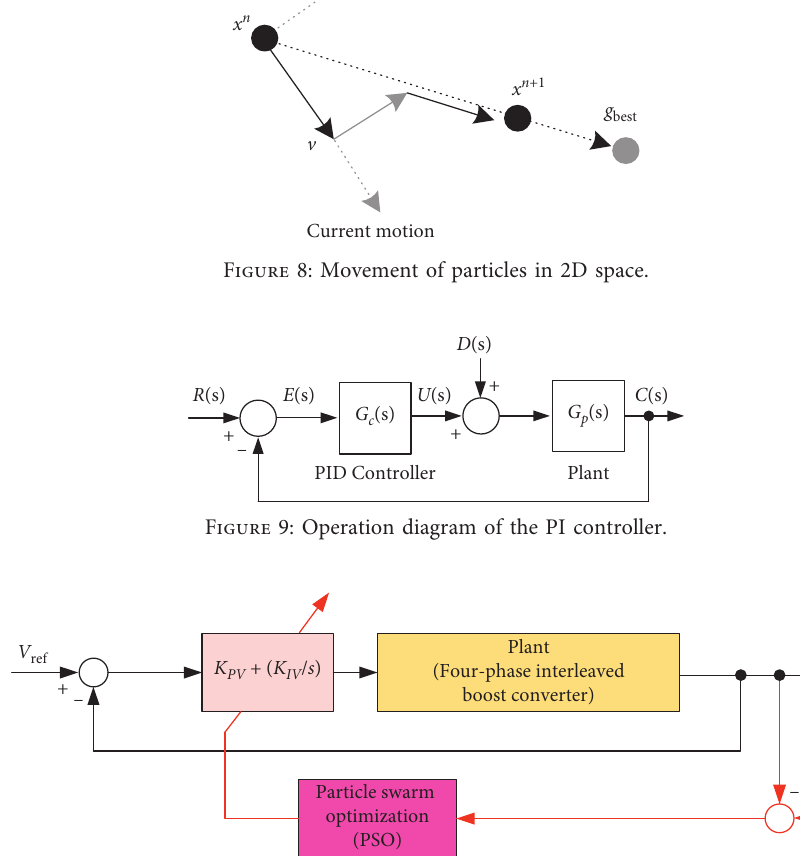
Figure 10: Operation diagram of the PI controller design using PSO search to control four-phase interleaved boost converter circuit